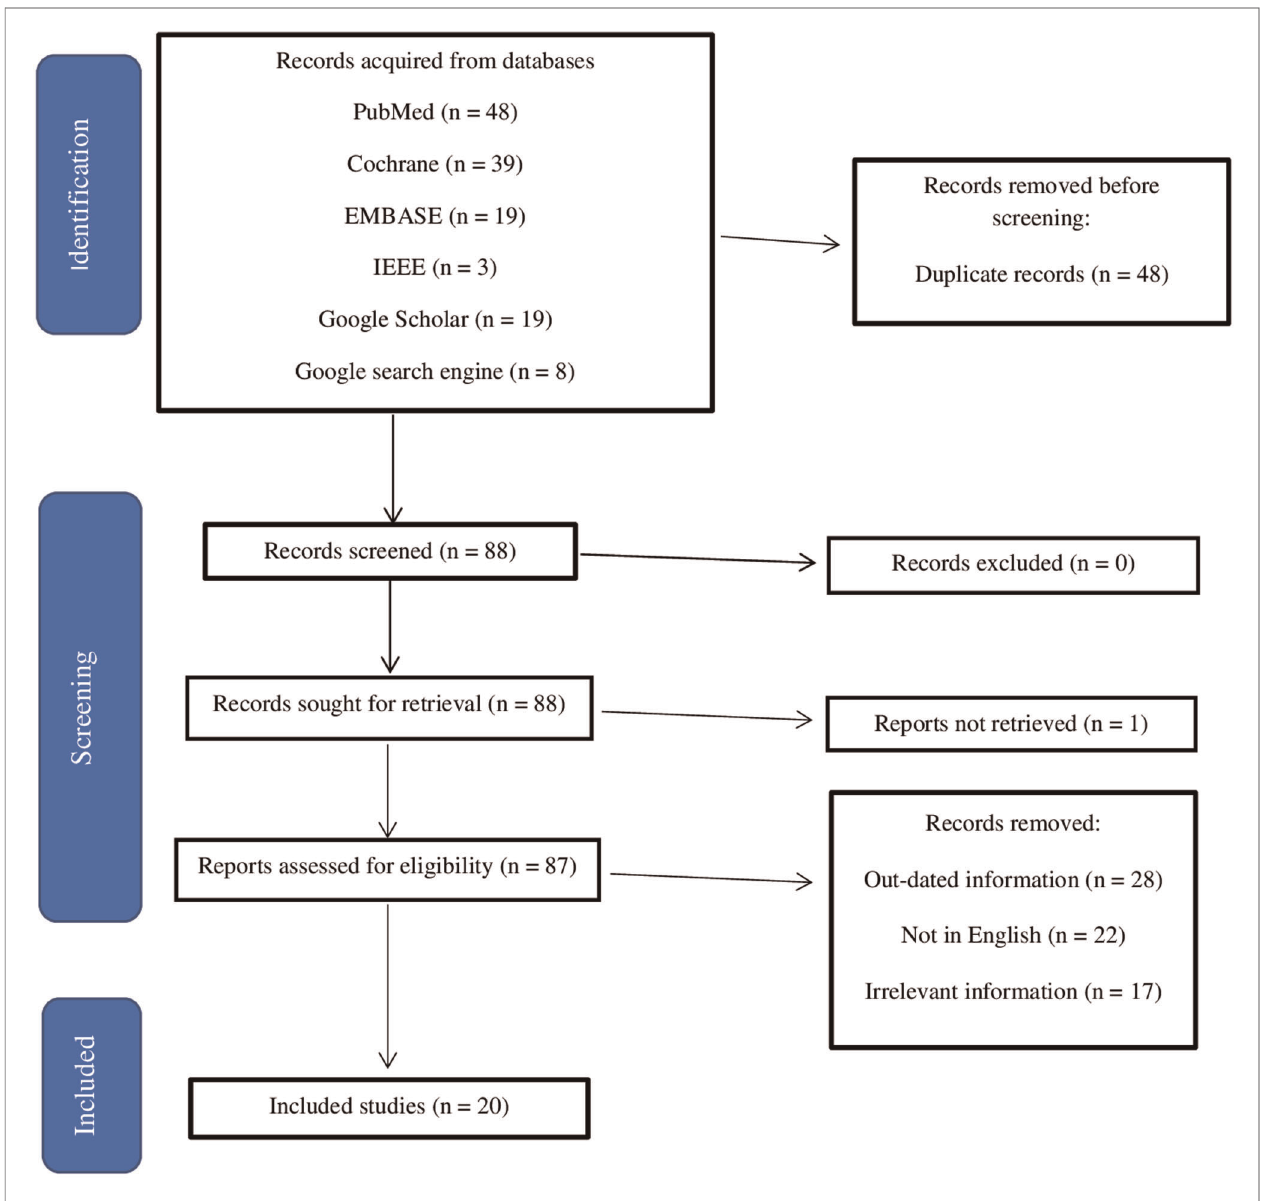
FIGURE 1 | Inclusion and exclusion criteria for this